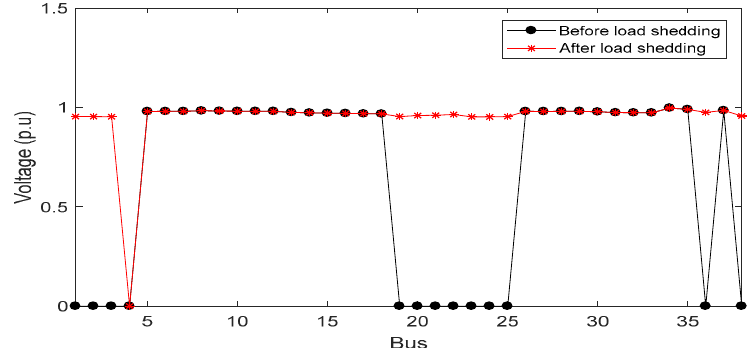
Figure 9. Bus voltages at faulted bus #4 prior to and after load shedding.